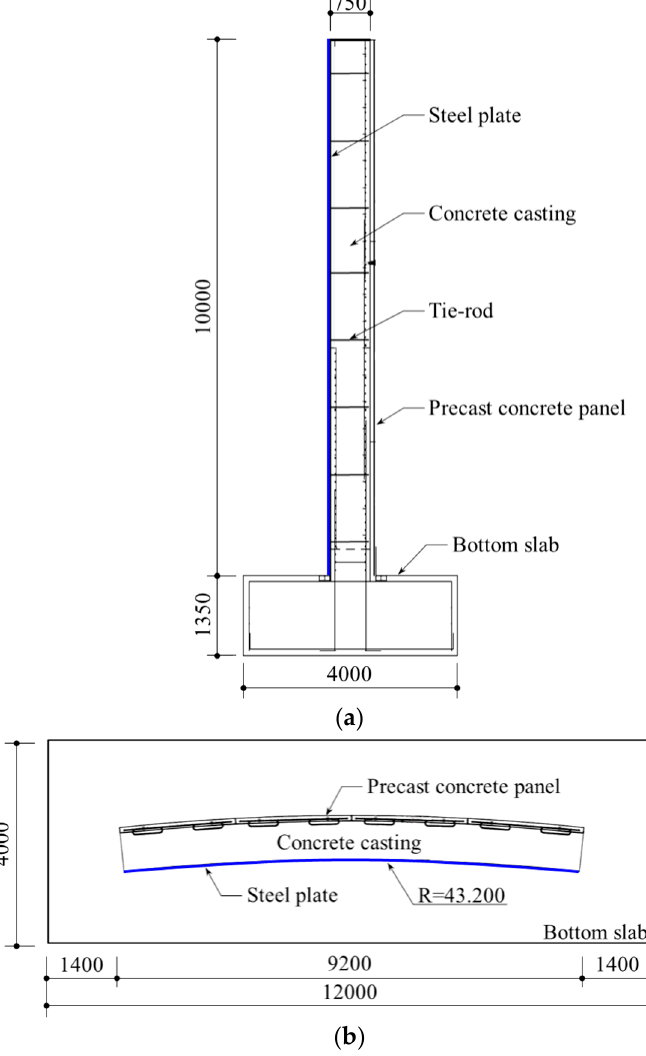
Figure 4. Detailed drawing of the mock ‐ up [Unit: mm ]: ( a ) Side view; ( b ) Top view.